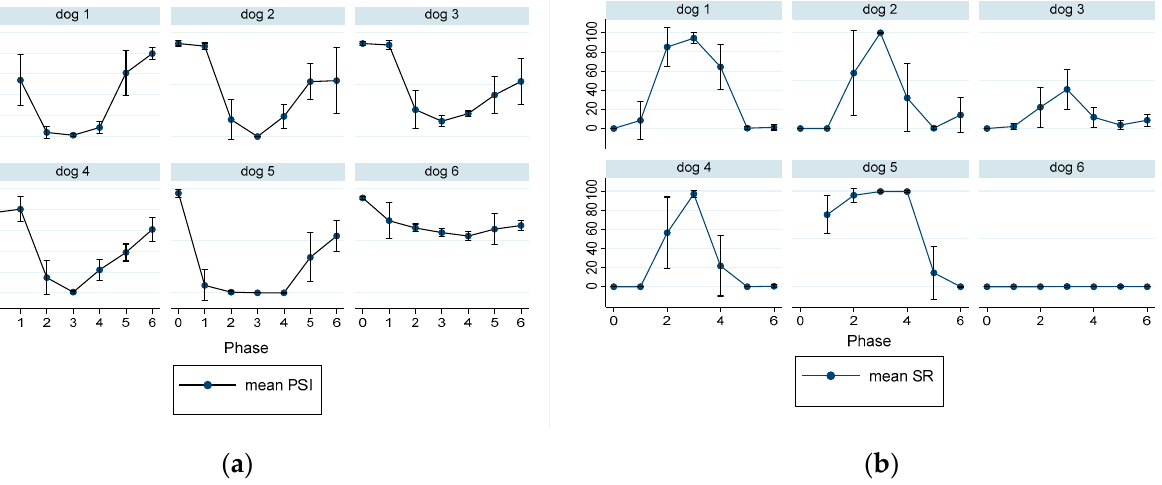
Figure 6. The individual response to propofol was reflected by the different degrees of patient state index (PSI—( a )) and burst suppression ratio (SR—( b )) across the anesthetic phases in six dogs. The data expressed as mean ± SD for phase 0 (awake), phase 1 (induction), phase 2 (2.4 mg/kg/min), phase 3 (1.2 mg/kg/min), phase 4 (0.6 mg/kg/min), phase 5 (extubation), and phase 6 (recovery to sternal). A shape contrast between dog#5 and #6 in PSI and SR was noticed with dog#5 having much more profound CNS depression indicated by a lower PSI and a higher SR during the same phase of propofol anesthesia than dog#6.